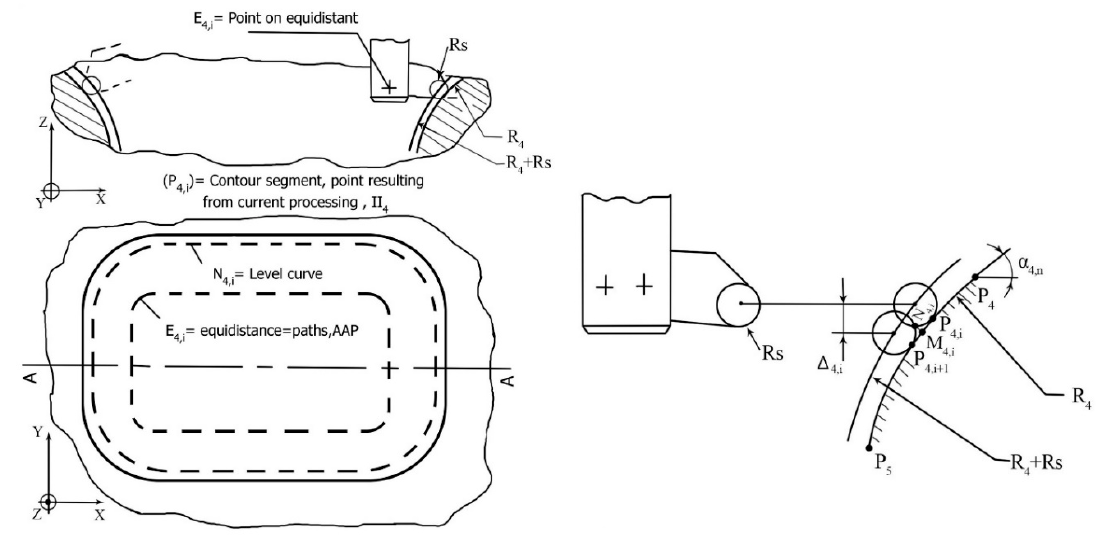
Figure 8. Level curve, the contour of the piece and the trajectory of the equidistance achieved by the tool.